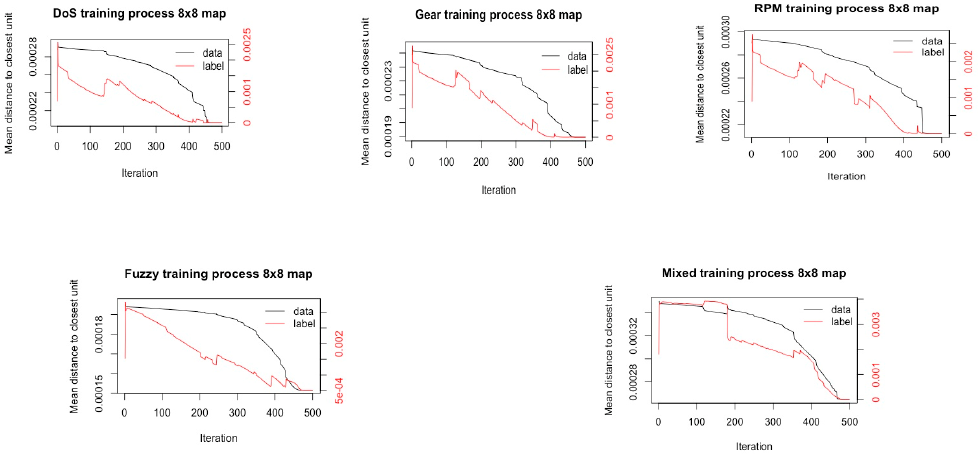
Figure 13. XYF Kohonen network training process for the 8 × 8 maps.